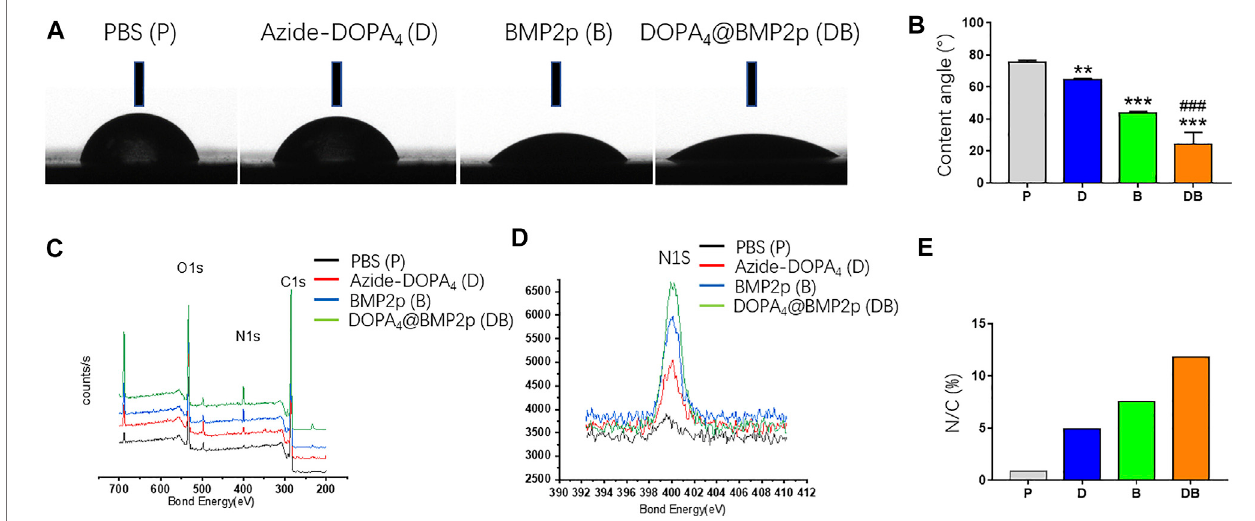
FIGURE 2 | Surface characterization of PEEK after different modi fi cations. (A) Images of corresponding water contact angles. (B) Quantitative results of water contactangles. (C – E) XPSspectraandthesurfaceN/CelementalratiosofPEEKsubstratesafterdifferentmodi fi cations. Statisticallysigni fi cantdifferencesareindicated by ** p < 0.01 or *** p < 0.001 compared with the PBS-PEEK group and ### p < 0.001 compared with the BMP2p group. Abbreviations: P (PBS), D (Azide-DOPA 4 ), B (BMP2p), and DB (DOPA